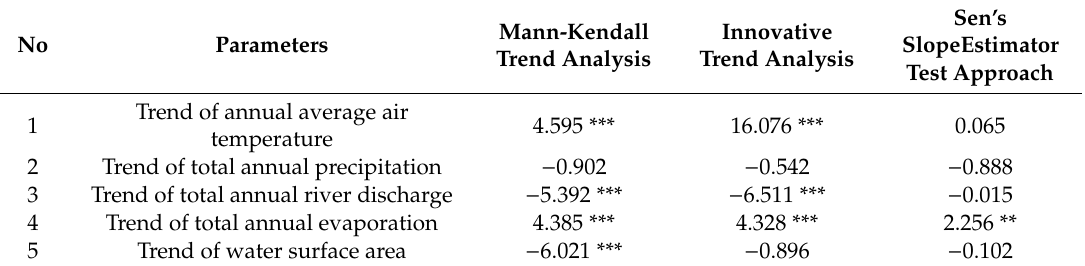
Table 2. Comparison of results by Mann-Kendal (MK), Innovative Trend (ITAM), and Sen’s Slope Estimator